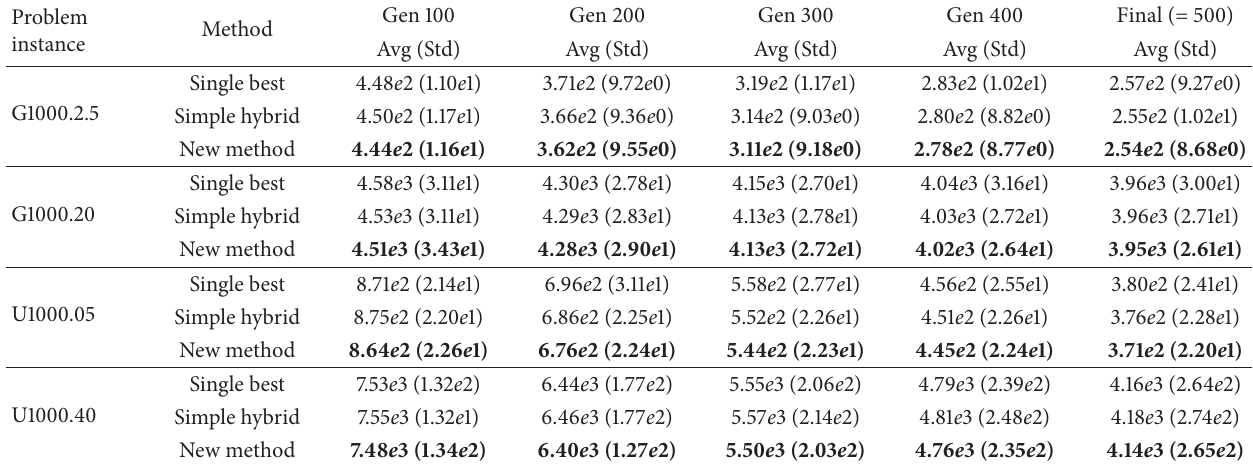
Table 4: Results of graph bisection.